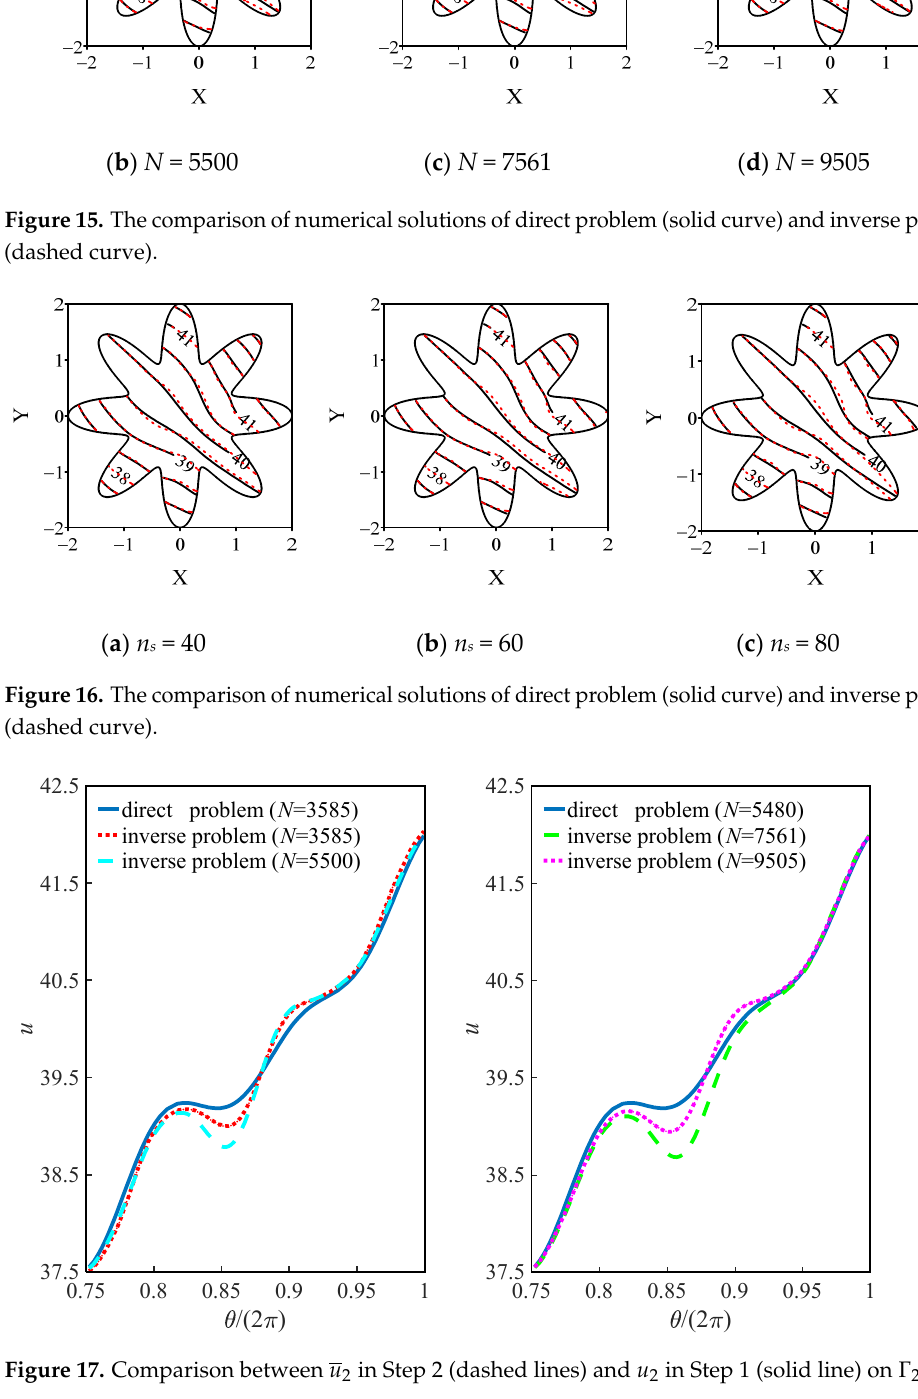
Figure 17. Comparison between u 2 in Step 2 (dashed lines) and u 2 in Step 1 (solid line) on Γ 2